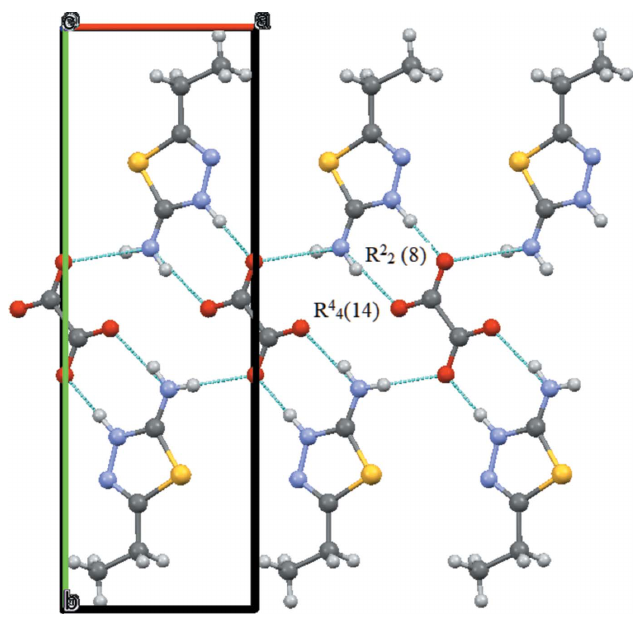
Figure 3 Packing diagram of compound (I) viewed down the c –axis. Hydrogen bonds are shown as dashed lines.